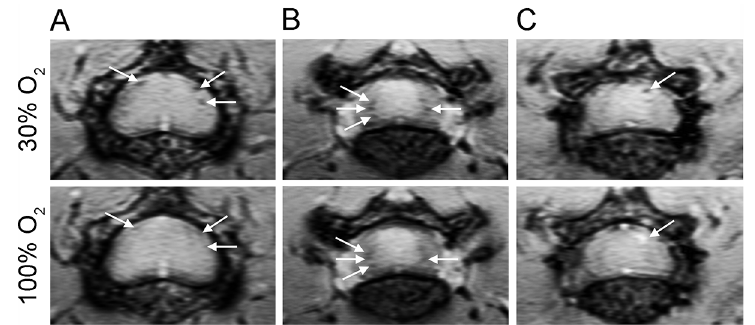
Fig 1. Deoxyhemoglobin-based SWI hypointensities in the lumbar spinal cords of EAE mice that appear hypointense with 30% O 2 show various responses upon administration of 100% O 2 . (A) Some hypointensities seen with 30% O 2 disappear with 100% O 2 (white arrows). (B) Some hypointensities seen with 30% O 2 become less dark with 100% O 2 , but do not disappear completely (white arrows). (C) Some hypointensities seen with 30% O 2 become hyperintense with 100% O 2 (white arrow).